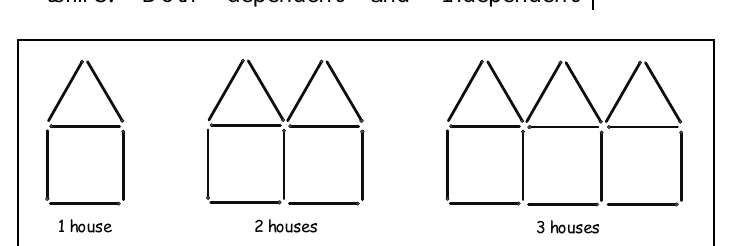
Figure 3. Three consecutive terms